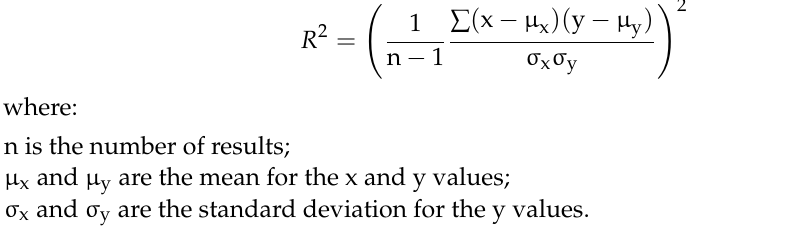
Figure 10. Soil results: relationship between PGA (ln) and settlement (ln).